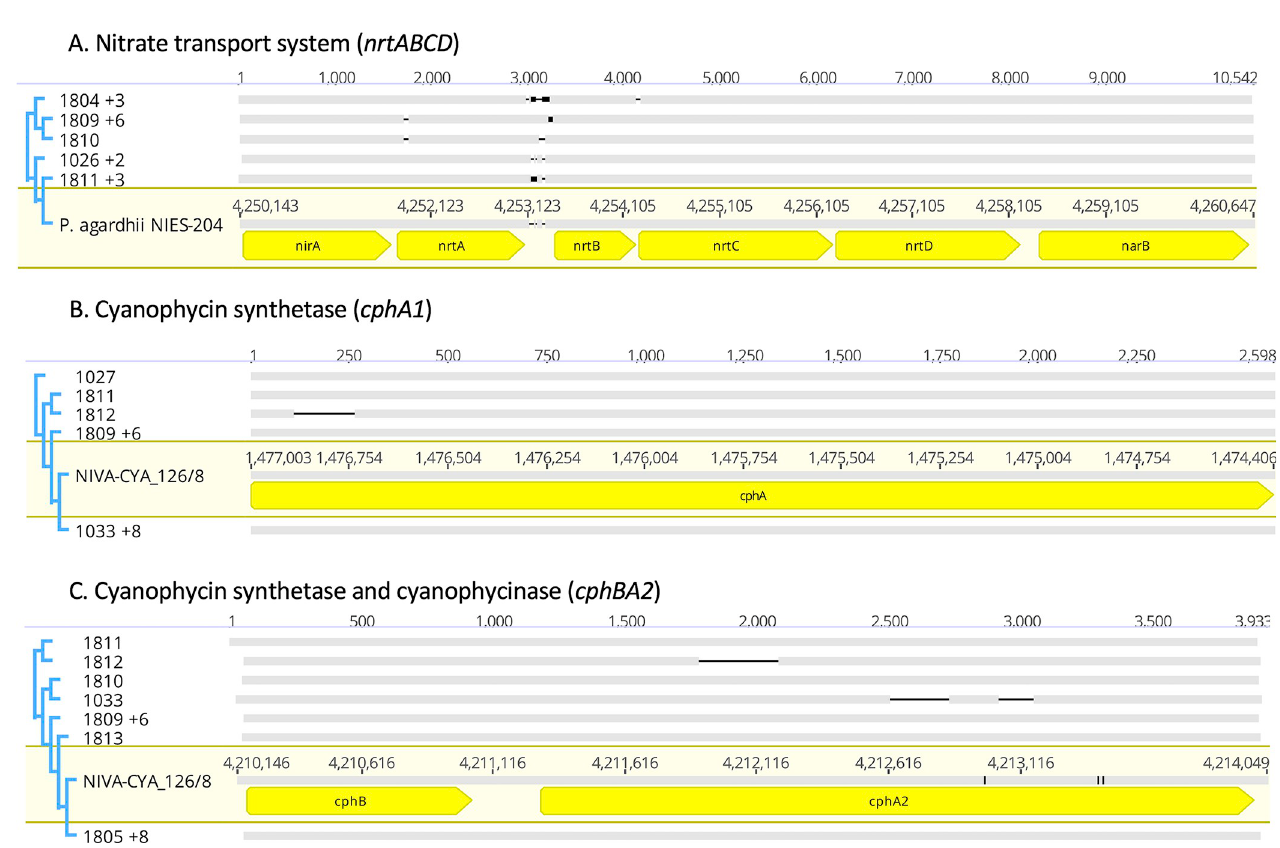
Fig 7. Nitrogen acquisition and storage genes found in P . agardhii . A. Sequence alignment of the nrtABCD cluster in reference NIES-204 and the P . agardhii isolates from Sandusky Bay. B. Sequence alignment of cyanophycin synthetase cphA1 . C. Partial sequence alignment of cyanophycinase ( cphB ) and cyanophycin synthetase chpA2 operon.